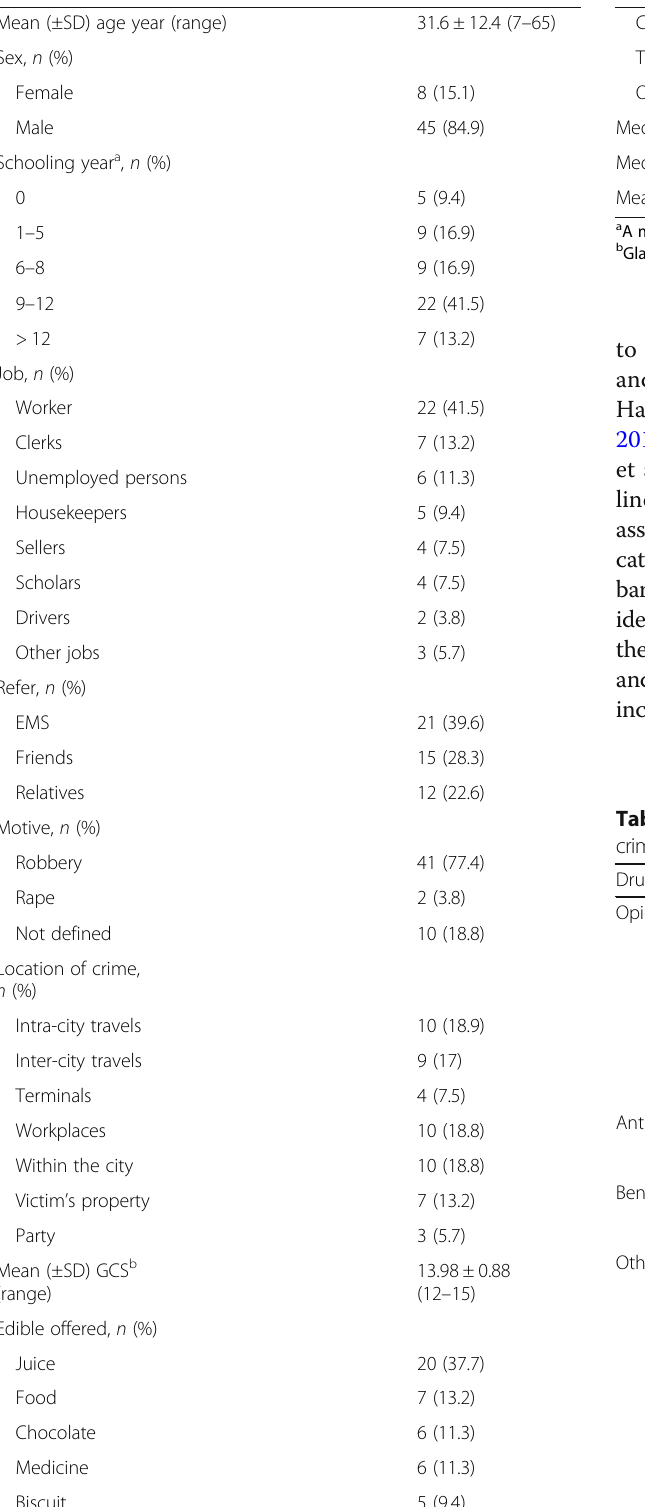
Table 1 Demographic and basic characteristics of the drug- facilitated crime victims (Continued) Results